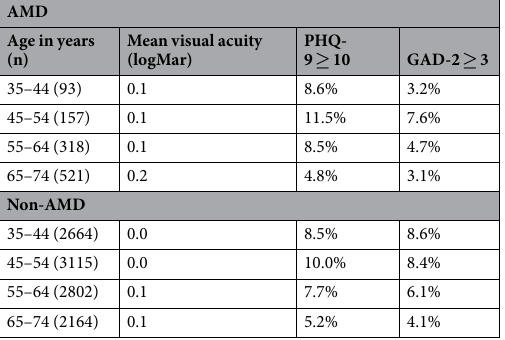
Table 3. Depression and anxiety prevalence in AMD participants by age and visual acuity. Abbreviations: AMD (age-related macular degeneration), GAD-2 (Generalized Anxiety Disorder Scale), PHQ-9 (Patient Health